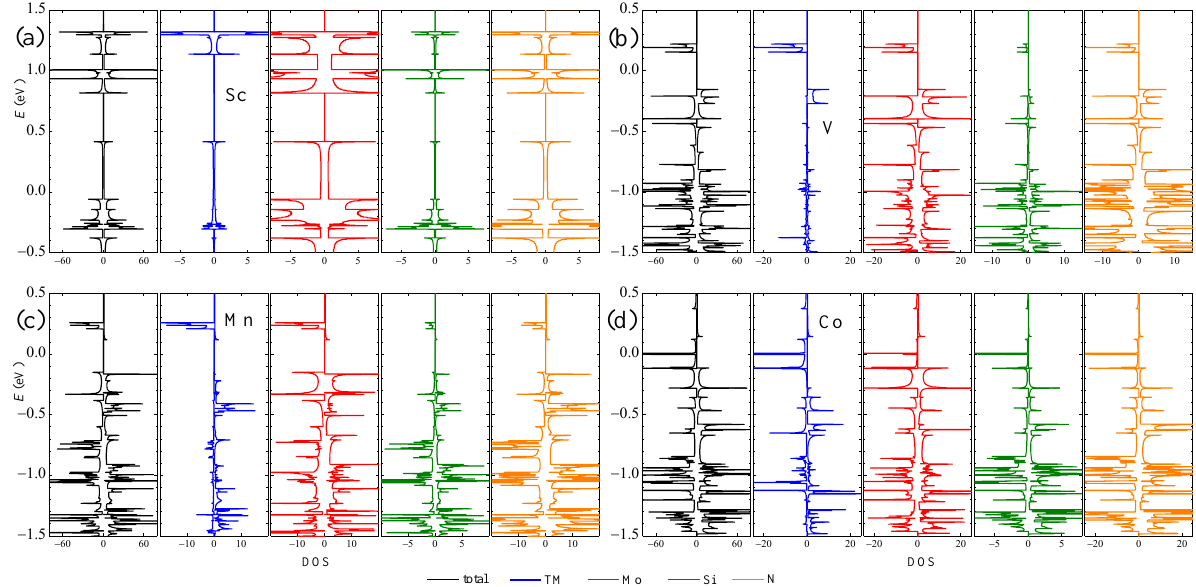
Figure 5. DOS/PDOS of ( a ) Sc-, ( b ) V-, ( c ) Mn- and ( d ) Co-doped aMoSiNNRs. The spin-up and spin-down components are plotted on the positive and negative sides, respectively.